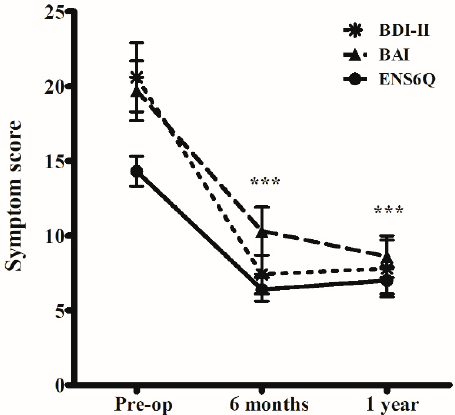
Figure 1. Subjective evaluations of patients with empty nose syndrome (ENS) perioperatively. Surgical reconstruction of nasal cavity by submucosal Medpor implantation (Stryker, Kalamazoo,